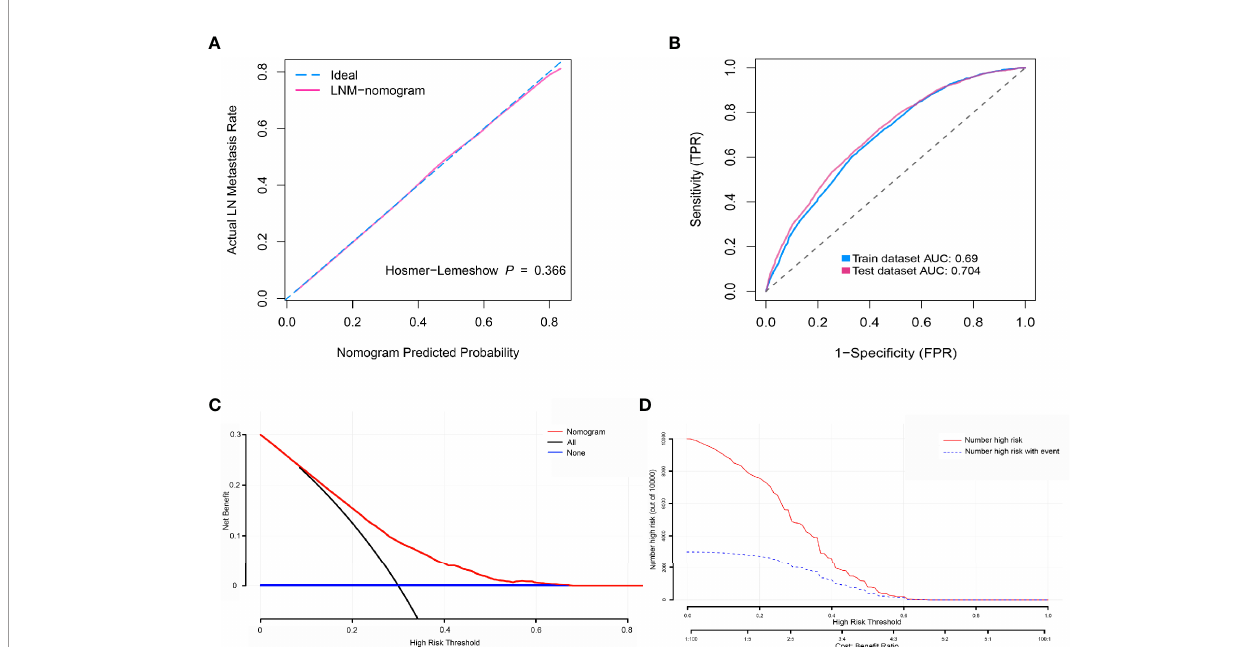
FIGURE 2 | Calibration curve, receiver operating characteristic curve, decision curve analysis (DCA), and clinical impact curve for predicting lymph node metastasis (LNM) in patients with bladder cancer (BCA). (A) Calibration curve of positive lymph node probability nomogram in the training set (bootstrap method, 1000 repetitions). (B) Area under the curve for predicting the LNM of patients with BCA in the training and veri fi cation sets. (C) The DCA curve of the training set. The x- axis and y-axis mean the threshold probability and net bene fi t, respectively. The black line indicates all patients experienced LNM, and the blue line indicates no patient developed LNM. (D) Clinical impact curve of the training set. The red curve demonstrates the number of people who were classi fi ed positive by the nomogram under each threshold probability, and the blue curve indicates the number of true positives under each threshold